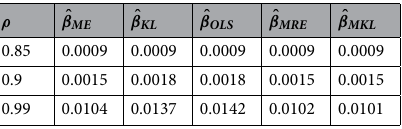
Table 6. Estimated MSE when σ